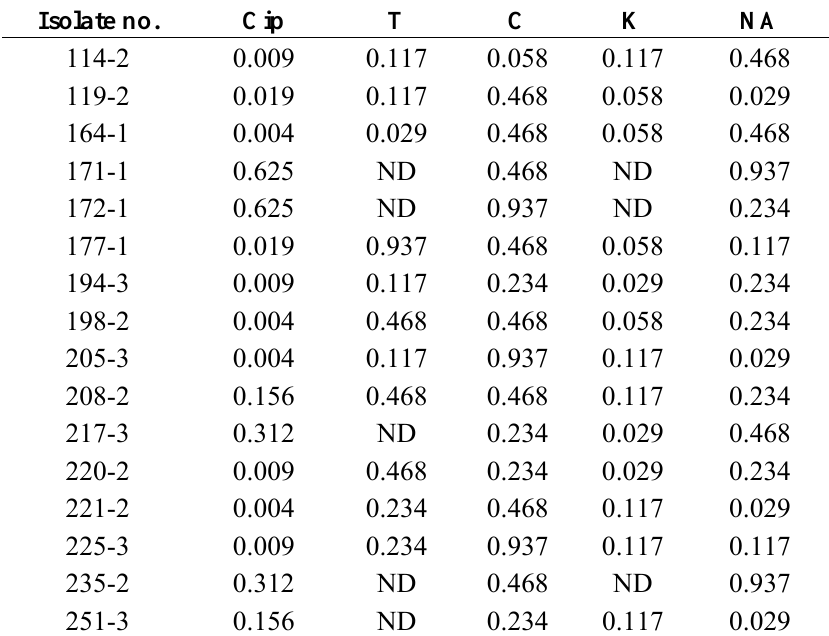
) of different antibiotics against 90